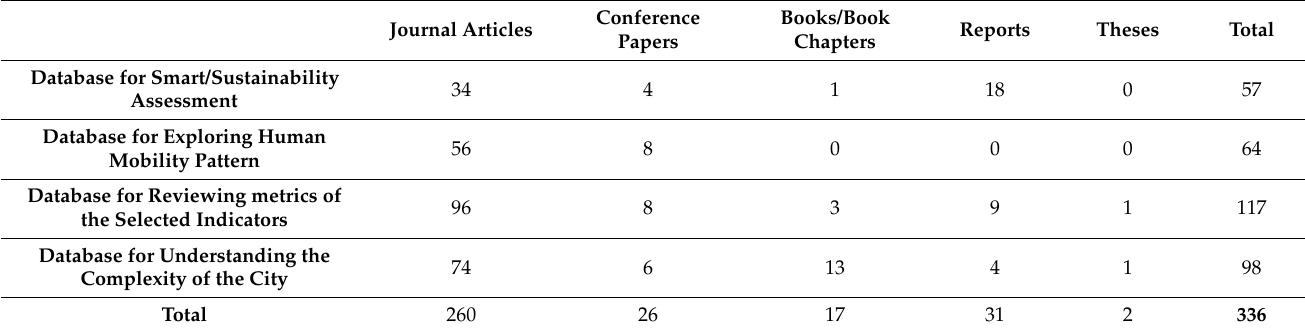
Table 2. The distribution of included documents in the literature